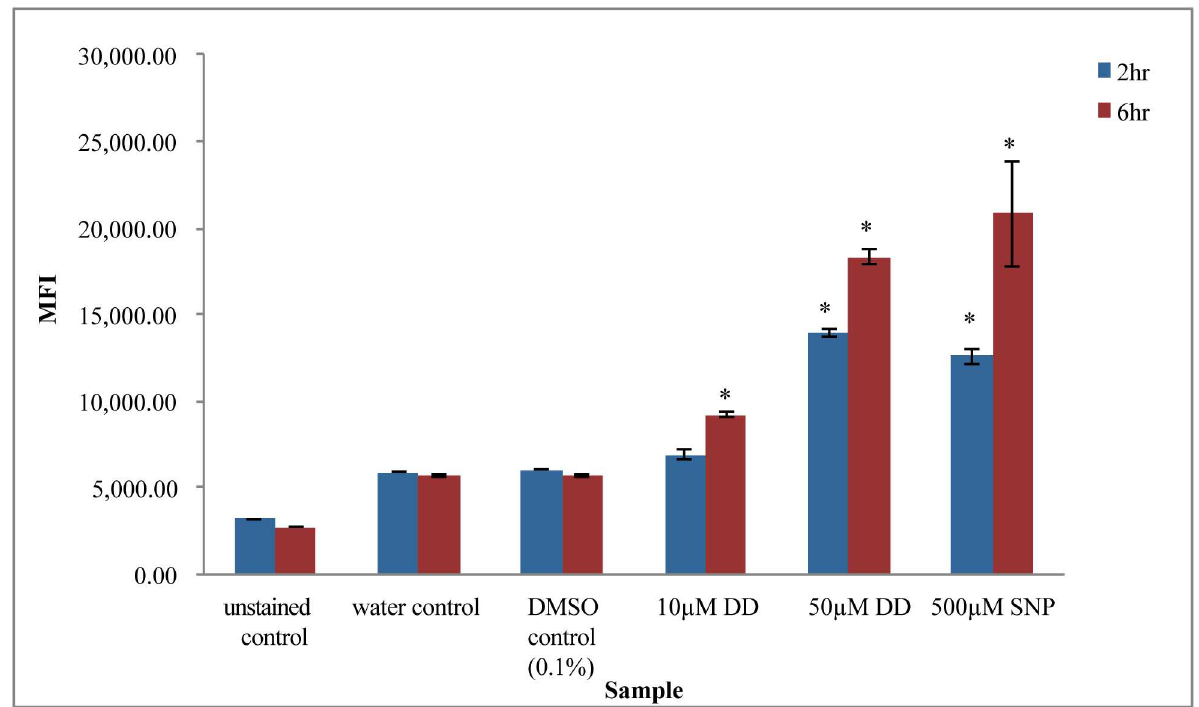
Fig 2. Effects of DD concentration and time on NO accumulation. NO accumulationin cells was measuredusing fluorescent dye DAF-FM diacetateby flow cytometry. MFI is MedianFluorescence Intensity. Unstainedcontrol and stainedDMSO (0.1%) solvent control were used as negativecontrols. SNP (which is a NO donor) at 500 µ M. acted as positive control. Error bars represent standard error. ( * Significance with respect to DMSO solvent control calculatedby student’s t-test, p < 0.05,n = 3).